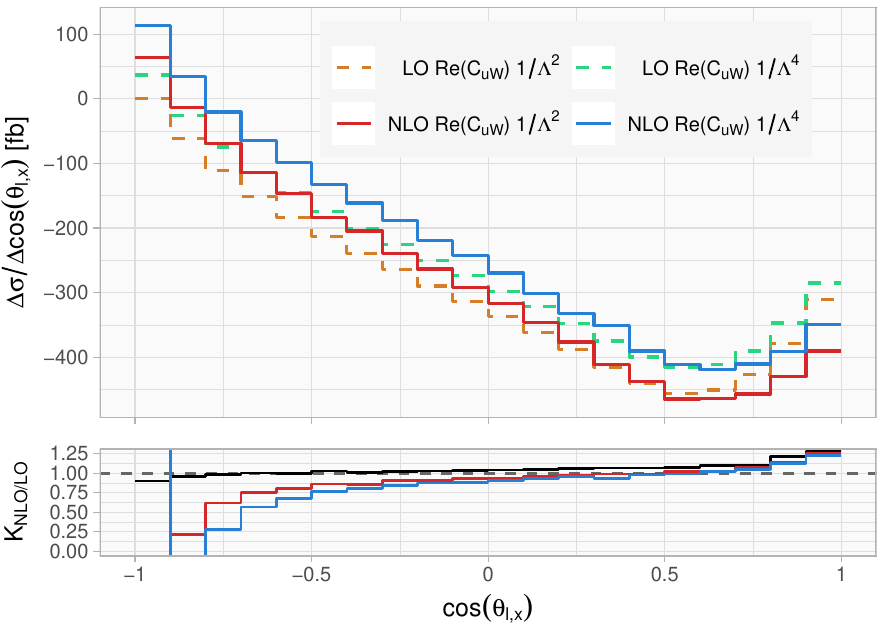
Figure 9. Distribution of cos (cid:18) l;x for the pure SMEFT contribution with Re C 33 1000 GeV. Shown are results at LO and NLO in QCD and at 1 = (cid:3) 2 in the SMEFT as well as with higher order e(cid:11)ects 1 = (cid:3) 4 .